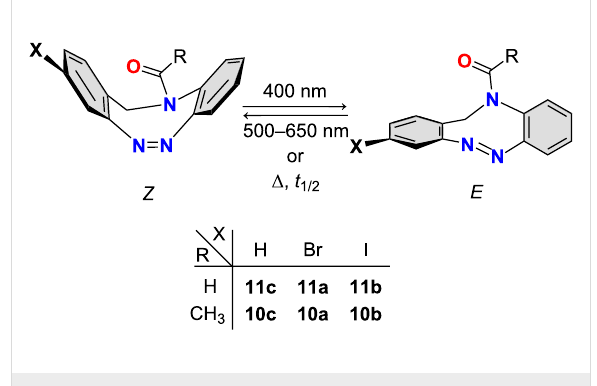
Figure 1: Bridged diazocines synthesized and investigated in this